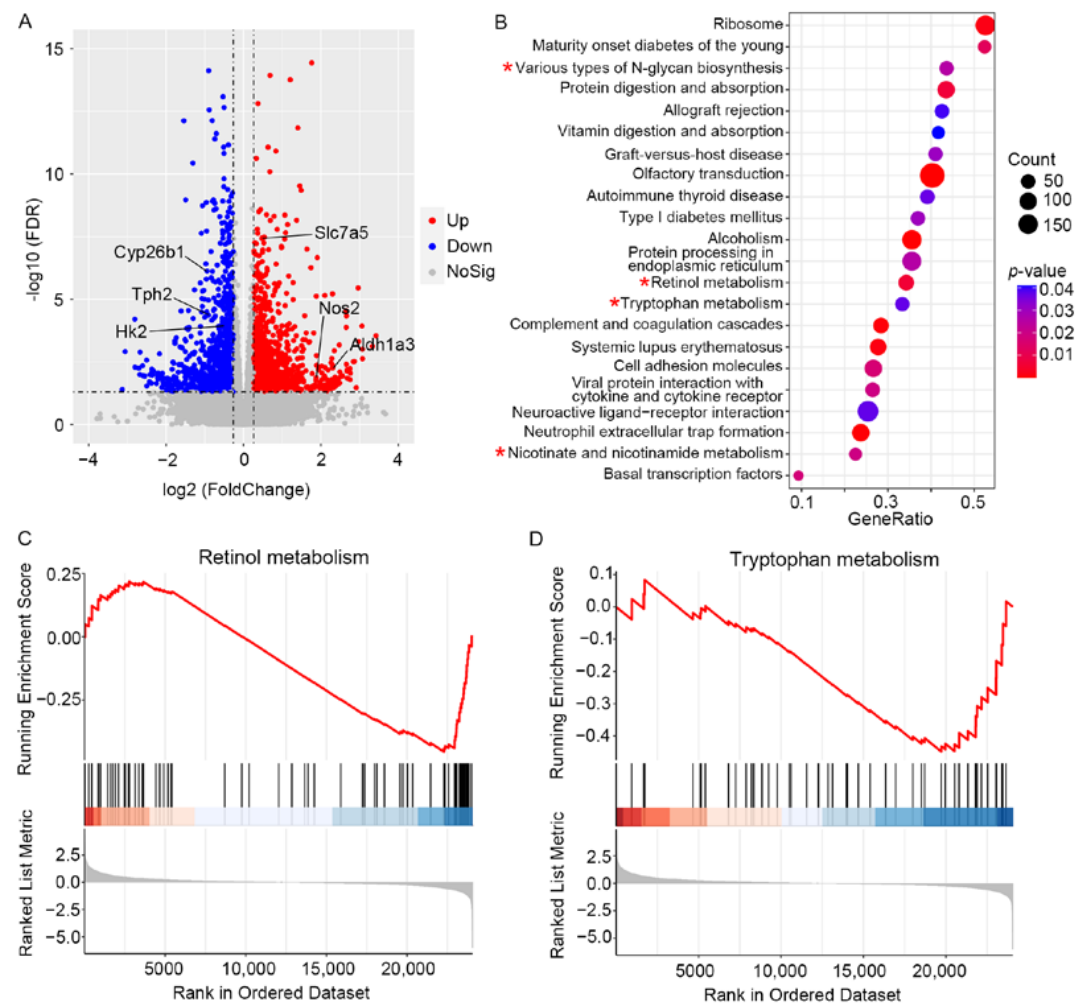
Figure 4. RNA-sequencing profiles demonstrated signatures of metabolism dysregulation in diabetic mice retina. ( A ) Volcano plot showing differentially expressed genes between two groups. Down-regulated and up-regulated metabolites are in blue and red, respectively. Non-significant metabolites are represented by gray dots ( p < 0.05). ( B ) Gene set enrichment analysis showed that 22 differential pathways differed between the STZ-induced diabetic group and control group ( p < 0.05, * metabolic pathway); ( C , D ) Two pathways were both enriched by metabolite and gene set enrichment analysis. ( C ) Gene set enrichment analysis of retinol metabolism. ( D ) Gene set enrichment analysis of tryptophan metabolism.